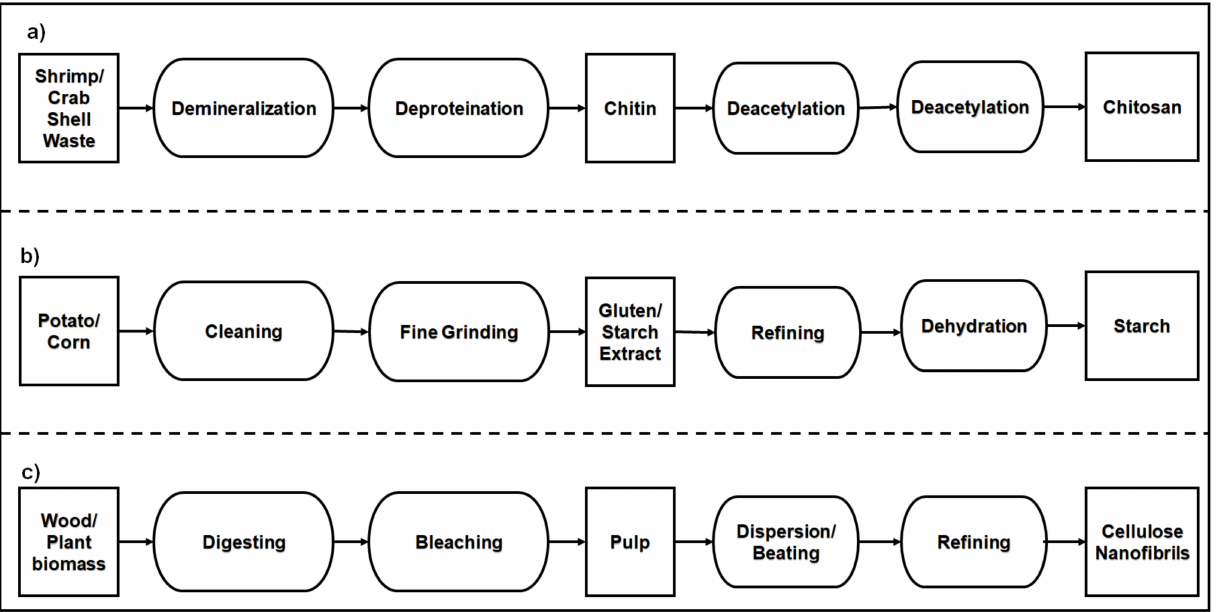
Figure 4. The production of polysaccharide natural polymers ( a ) Chitosan ( b ) Starch ( c ) Cellulose Nanofibrils